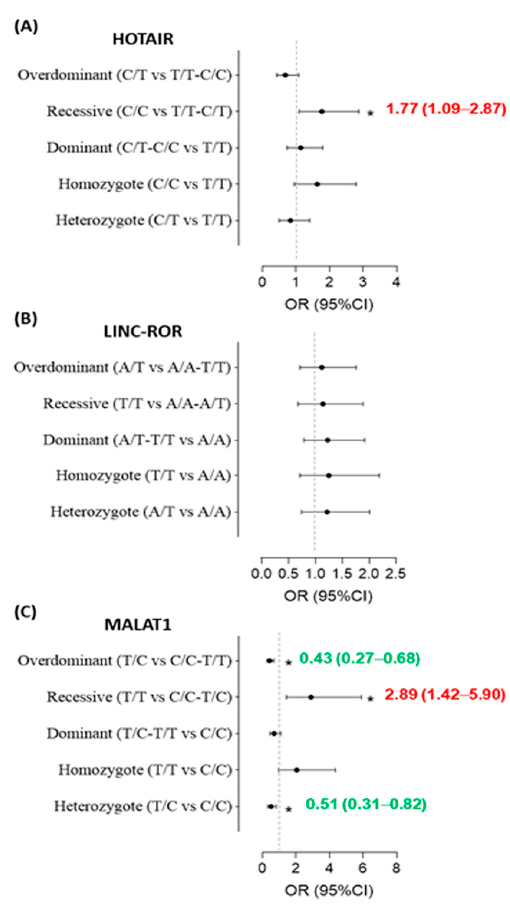
Figure 2. Risk of systemic lupus erythematosus by genetic association models of HOTAIR (A), LINC- ROR (B) , and MALAT1 (C) _genotypes . A Chi-square test was used. OR (95%CI), odds ratio, and confidence interval. * Statistically significant p -value ≤ 0.05. Adjusted covariates: age and sex. Increased/decreased susceptibility labeled with (red/green OR 95%CI), respectively.